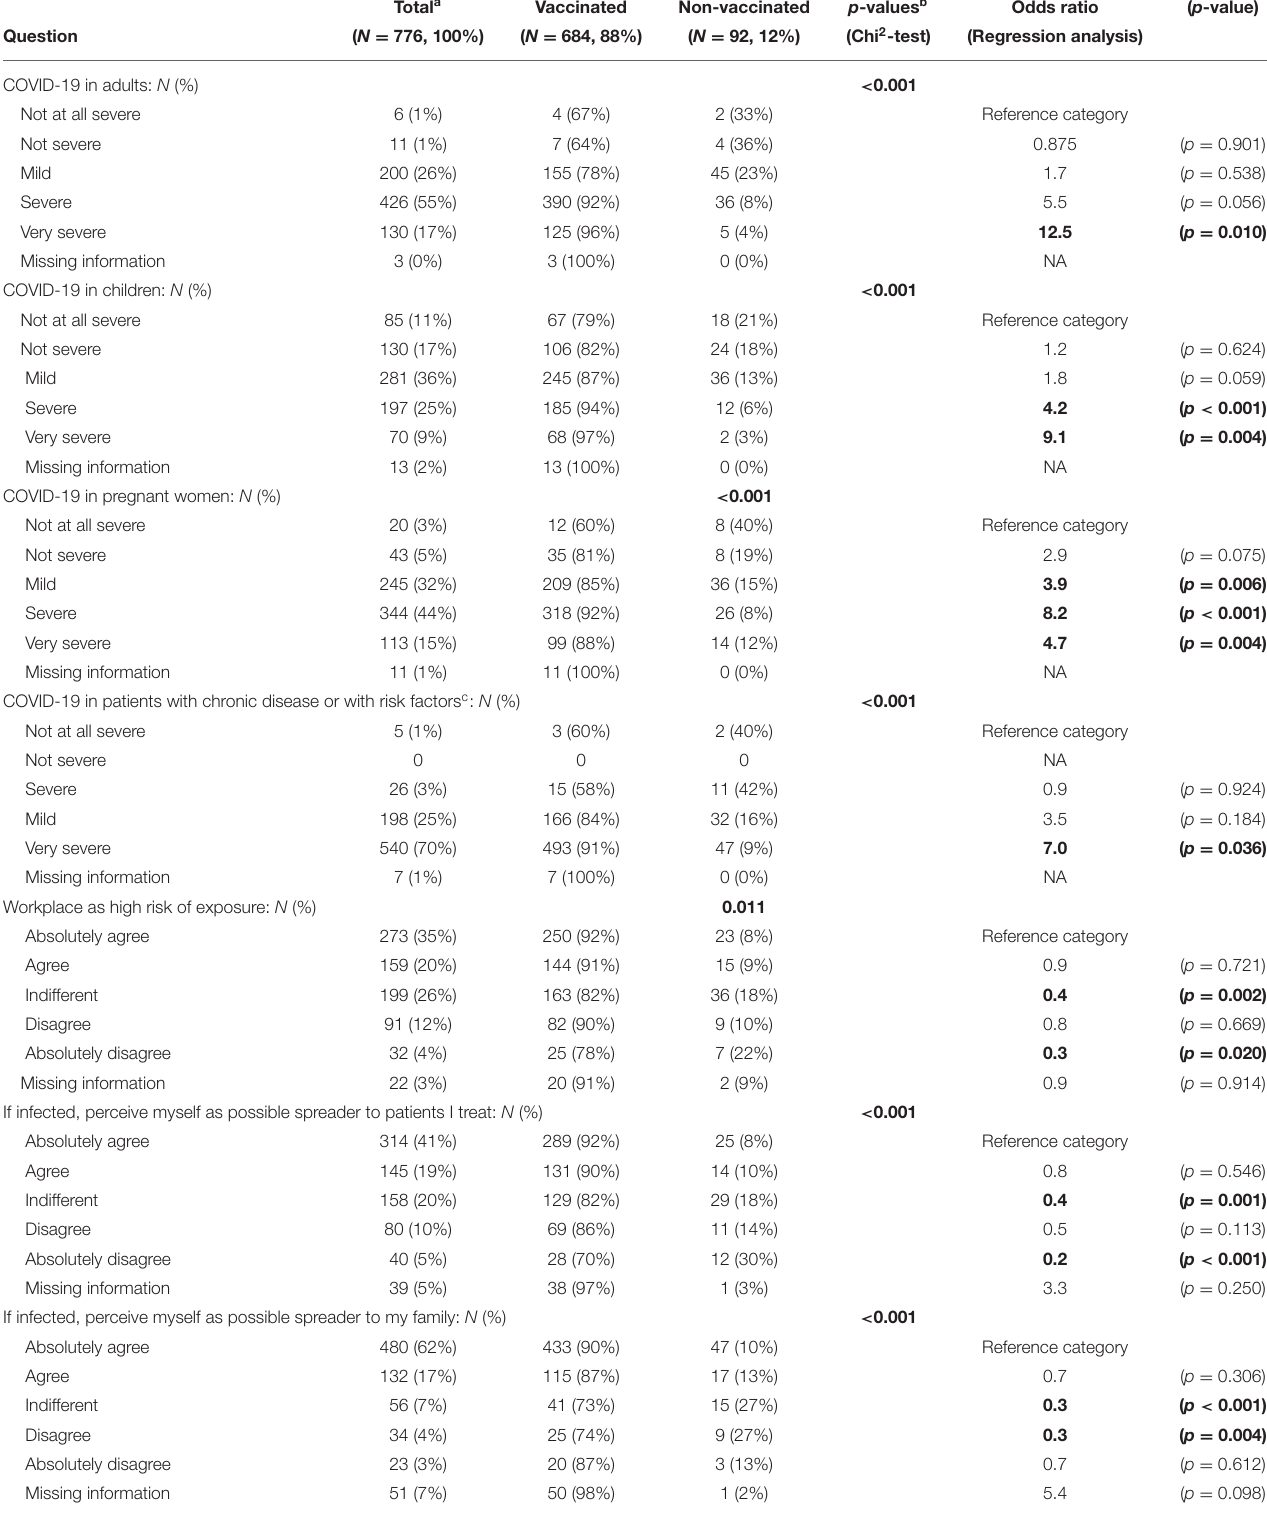
TABLE 2 | Perception on COVID-19 disease.